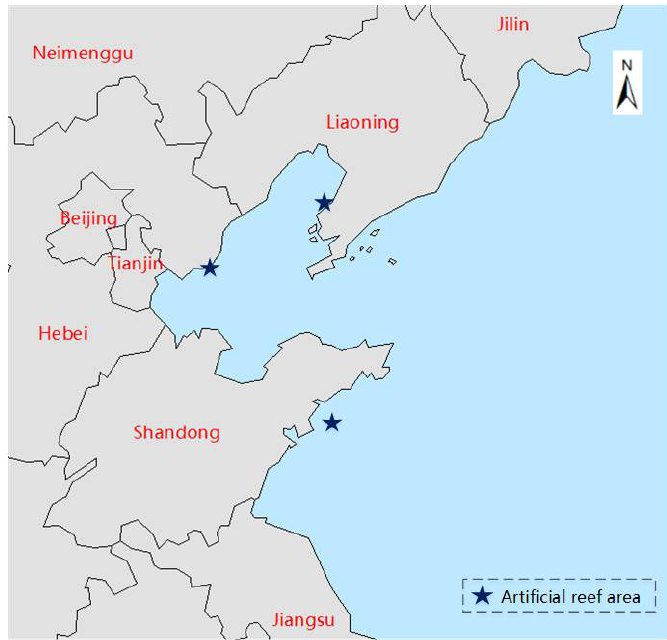
Figure 2. Distribution location of three artificial reef areas.